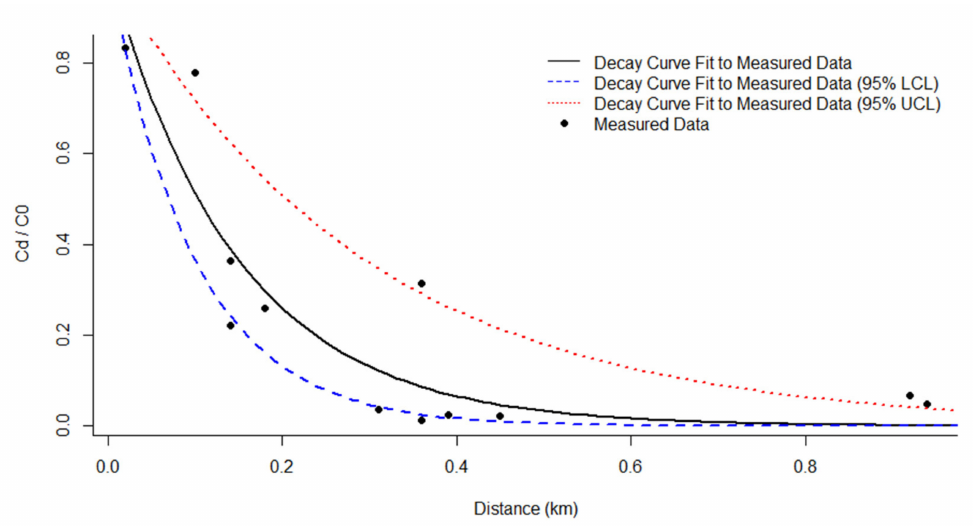
Figure 1. Exponential decay model of ratio C d / C 0 in ambient air by distance. Where, d : the distance (km), C d : the asbestos concentration at distance d (f/cc), C 0 : the asbestos concentration at distance 0